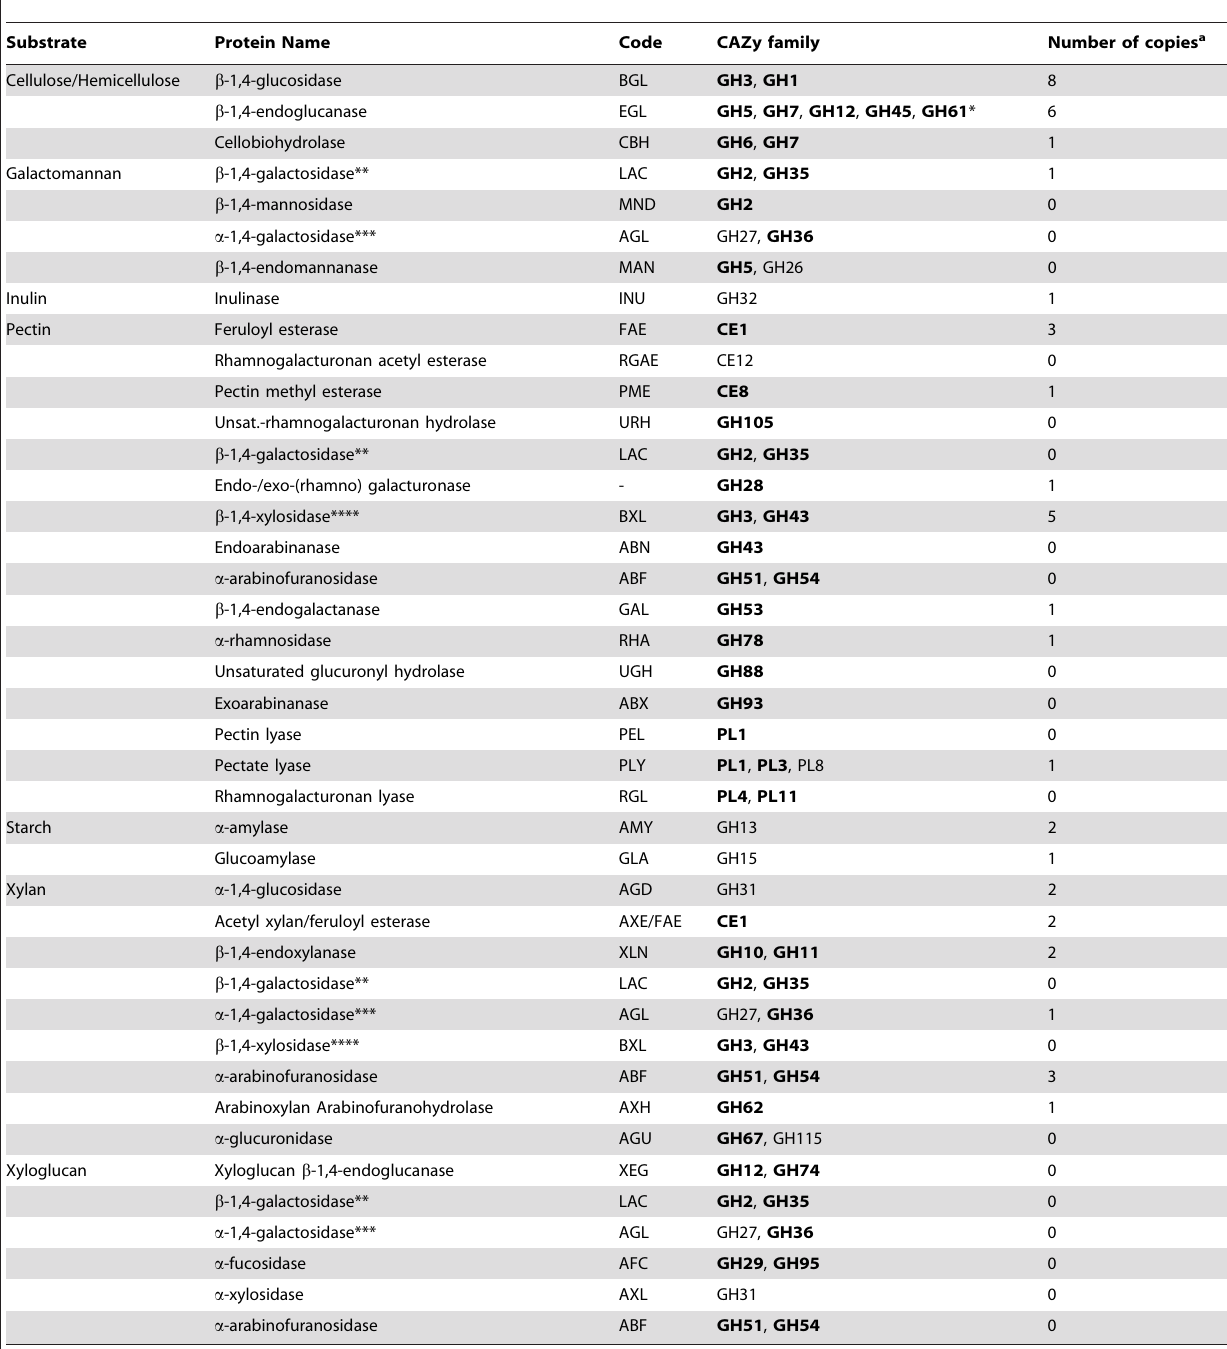
Table 5. The sub-set of total putative secreted proteins related to plant polysaccharides degradation found in M. graminicola .